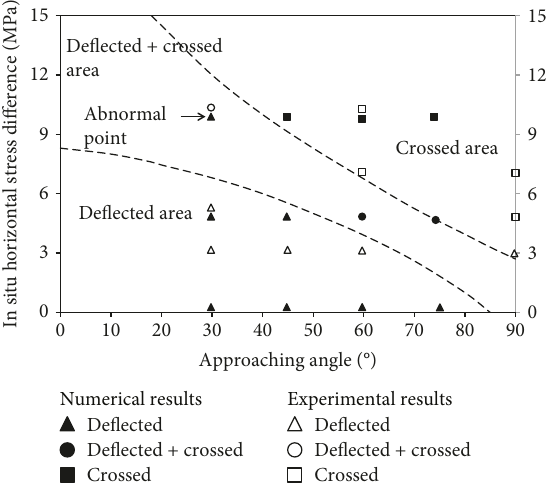
Figure 14: The in fl uence of the approaching angle on arti fi cial fracture propagation.